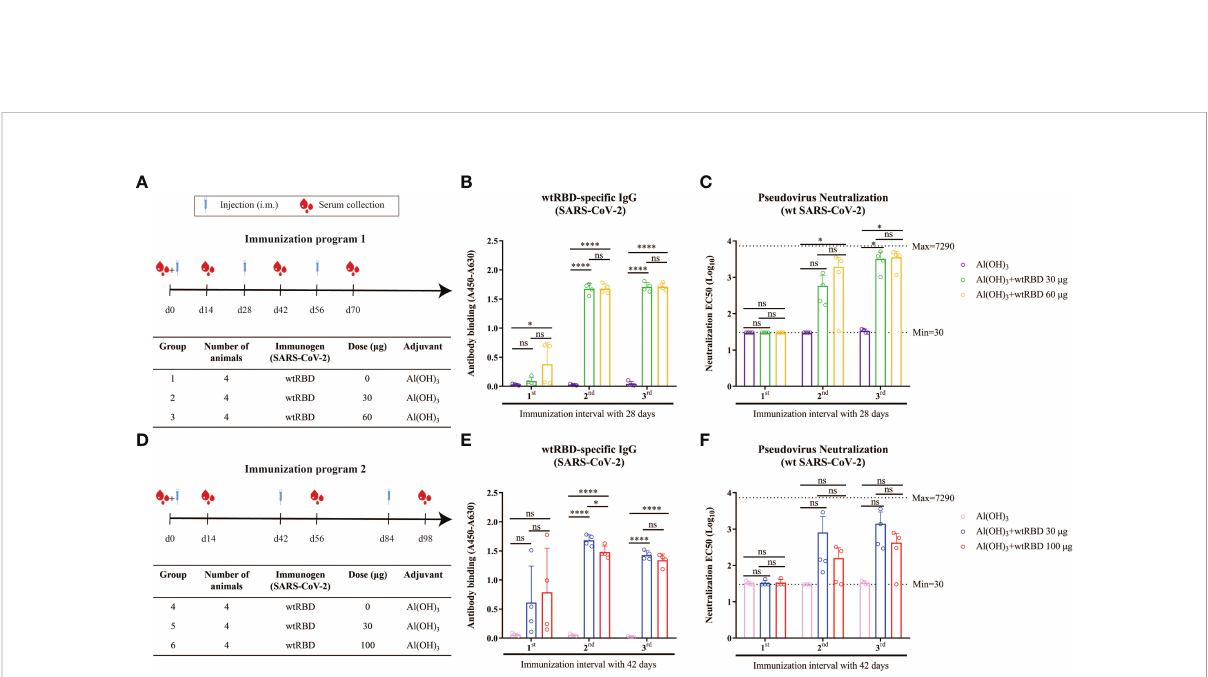
FIGURE 2 Humoral immune responses induced by yeast-expressed wtRBD in mice. Mice were intramuscularly immunized with different amounts of wtRBD with Alum adjuvant in two different immunization programs. The serum samples were collected at the fourteen day after each immunization and 1 st , 2 nd , 3 rd indicated the serum samples collected the fourteen day after the fi rst, second, and third immunization, respectively. The serum samples were diluted at a ratio of 1:100 for ELISA to detect IgG binding antibodies. NAbs were quanti fi ed based on a pseudovirus assay. (A) Schematic of immunization program 1. Each mouse received different amounts of wtRBD three times with a 28-day interval. (B) Detection of the wtRBD-speci fi c binding IgG antibodies in serum according to immunization program 1. (C) Quanti fi cation of NAbs in serum according to immunization program 1. (D) Schematic of immunization program 2. Each mouse received different amounts of wtRBD three times at 42-day intervals. (E) Detection of the wtRBD-speci fi c binding IgG antibodies in serum according to immunization program 2. (F) Quanti fi cation of NAbs in serum according to immunization program 2. Data are the mean ± SD. p -values were calculated using one-way ANOVA. * p < 0.05, **** p < 0.0001; ns, not signi fi cant.